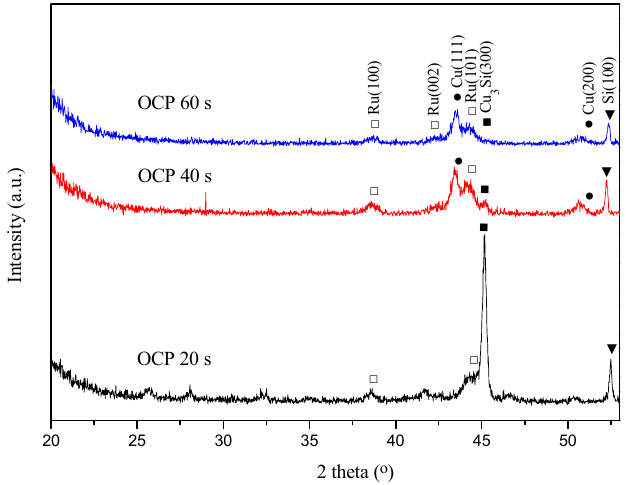
Figure 8. XRD results for the Cu(Mn) films annealed at 600 °C.